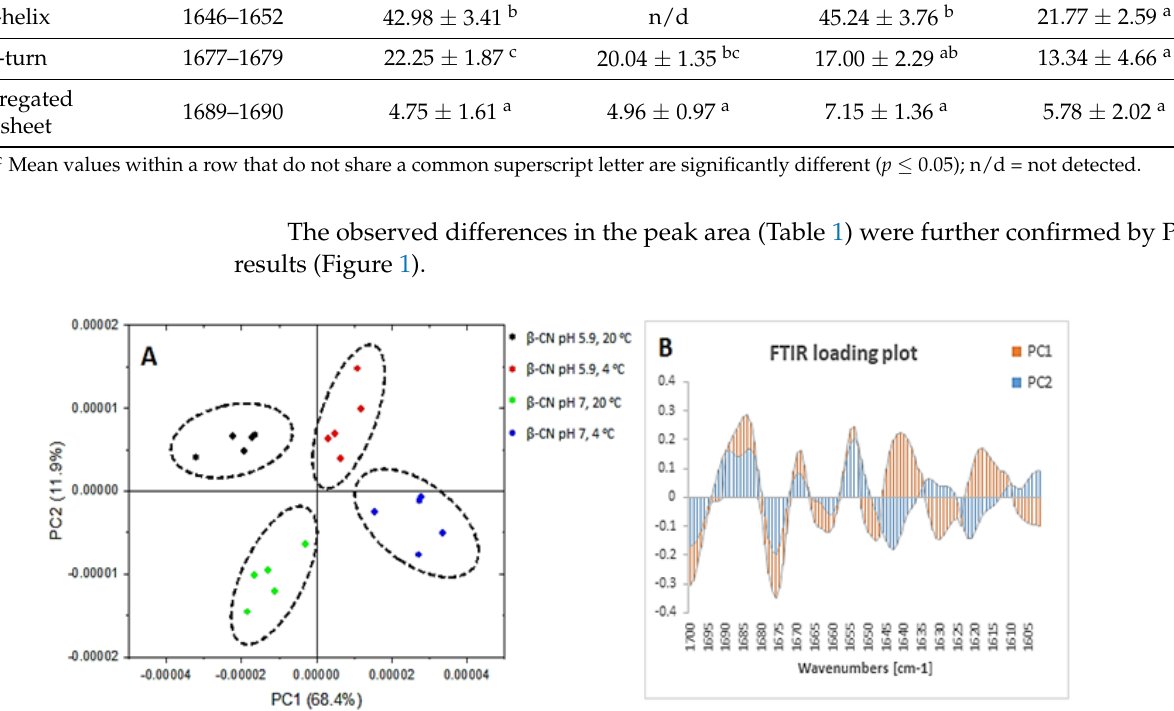
Table 1. Total percentage areas of different secondary structures in Amide I in β -CN in FTIR including side chain, β -sheet, random coil, α -helix β -turn, and aggregated β -sheets. The selected band frequency for each structural component is presented in cm − 1 . The peak area percentage is presented for temperature of 4 and 20 ◦ C and pH of 5.9 and 7.0. Band Frequency Band Assessment (cm − 1 )